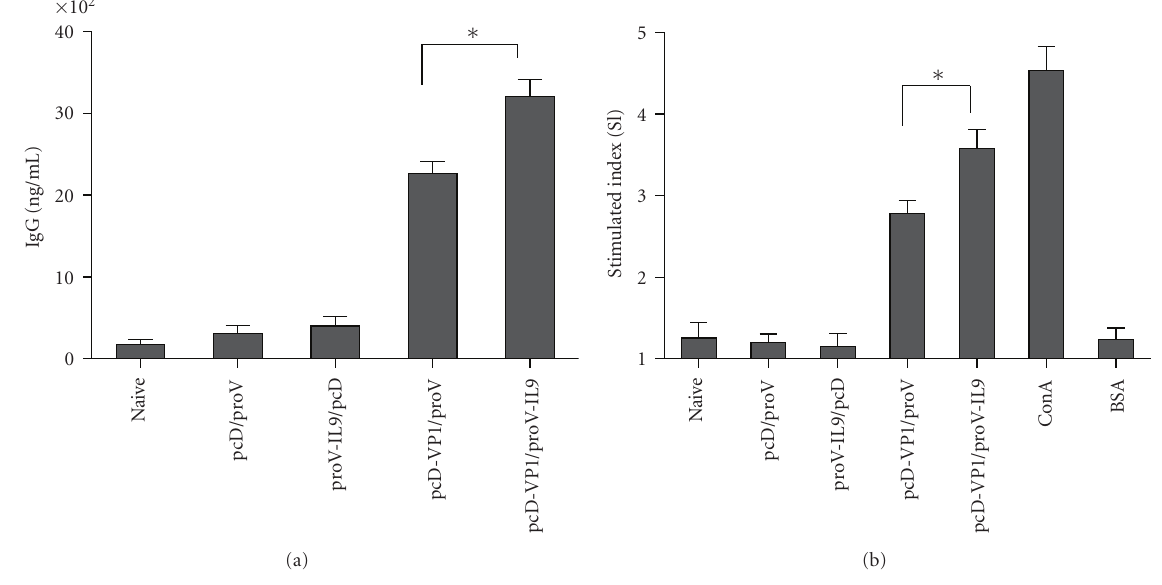
Figure 2: E ff ect of IL-9 as adjuvant on humoral and cell proliferative responses. (a) Serum samples from six mice per immunized group were analyzed for specific antibodies against VP1 by ELISA. Mouse IgG with a known concentration was serially diluted and a standard curve was obtained for concentration of specific binding. (b) T cells were isolated from mice (6 per group) of all groups on day 7 after the third immunization and stimulated with VP1 recombinant protein. A cell proliferation response was analyzed using MTT and expressed as stimulation index. Data showed are representatives from three independent experiments. ∗ P < . 05 compared with pcD-VP1